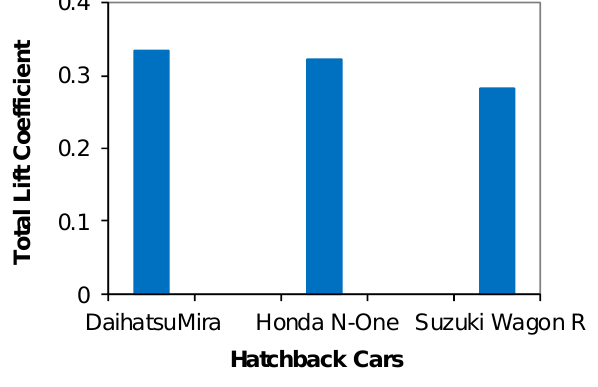
Fig. 16. Comparison of total lift coefficient of three hatchback vehicles